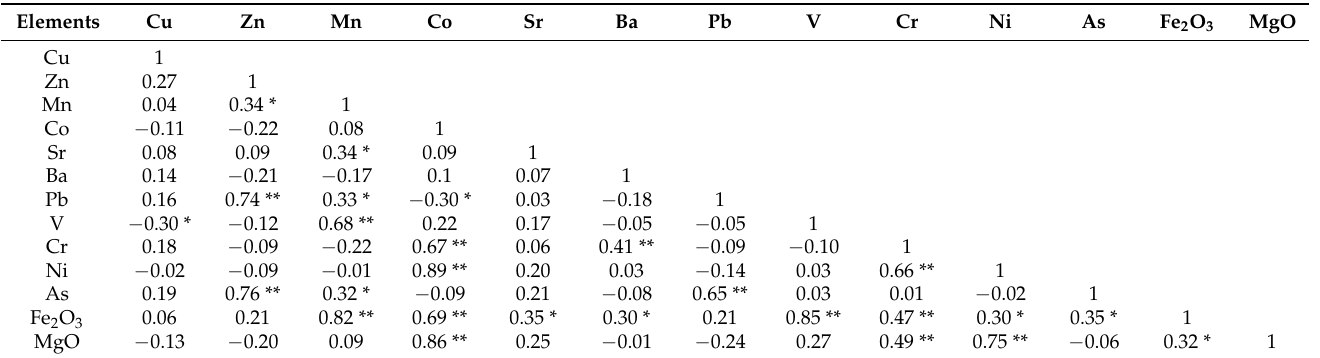
Table 5. The correlation coefficients among heavy